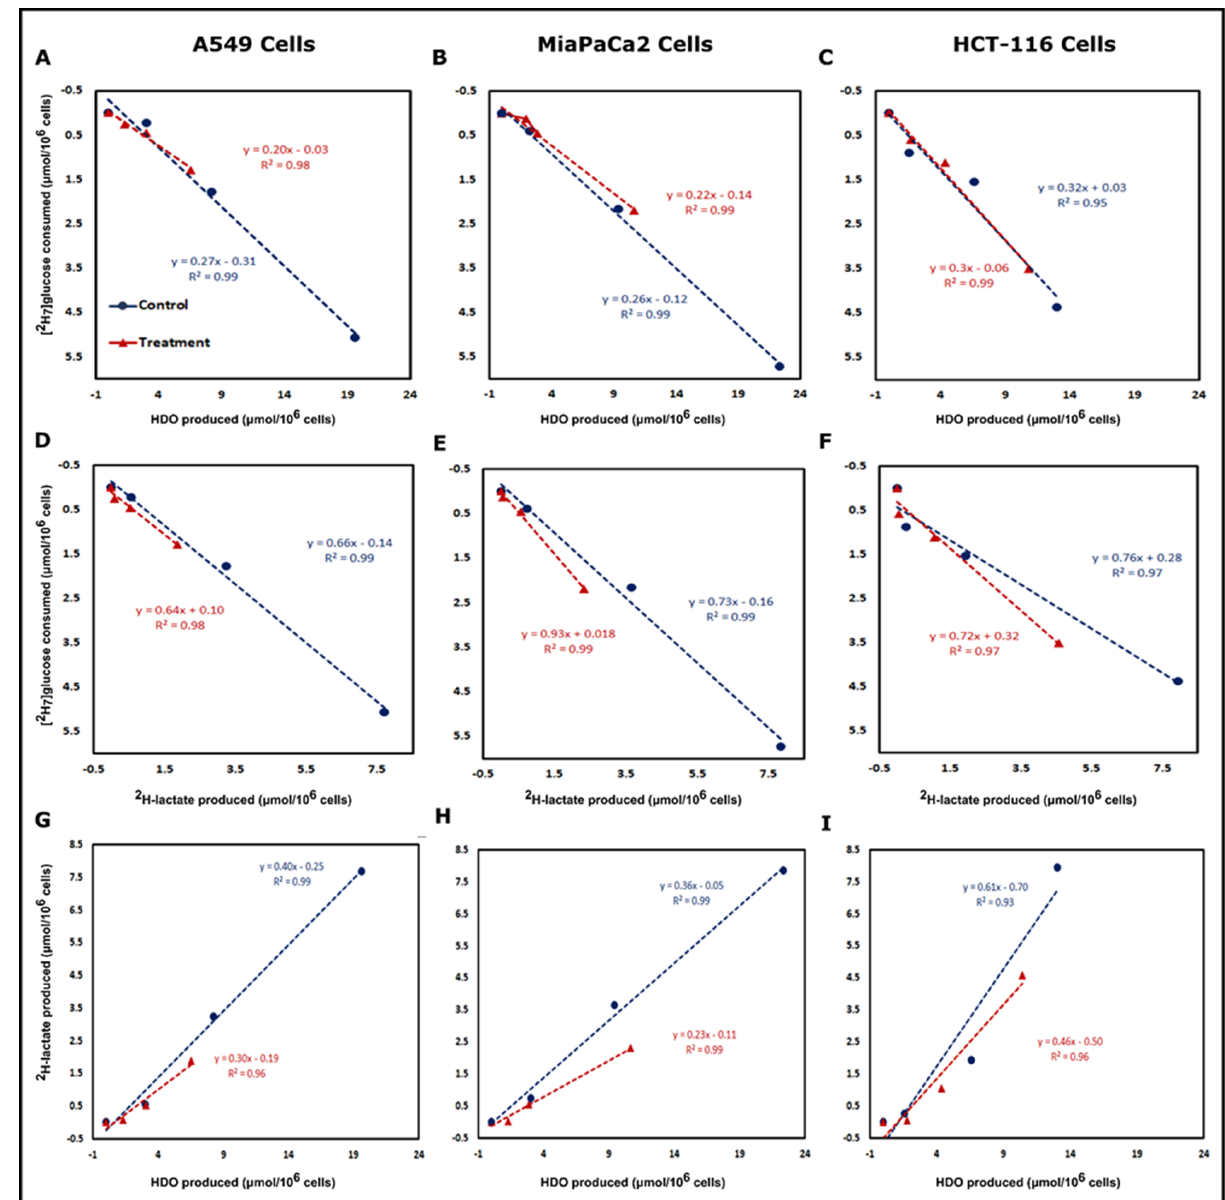
Figure 4. HDO and 2 H-lactate production are directly related to [ 2 H 7 ]glucose consumption. Correlation plots of [ 2 H 7 ]glucose consumption vs. HDO production (top row) and 2 H-lactate production (middle row) and correlation between 2 H-lactate vs. HDO production (bottom row) are shown for the post-treatment period of A549 (Panels A , D and G ), MiaPaCa2 (Panels B , E and H ) and HCT-116 (Panels C , F and I ). Correlations in all conditions were linear with R 2 values > 0.96. Correlation plots were plotted from the calculated concentration of consumed [ 2 H 7 ]glucose and produced 2 H-lactate and HDO by control and treated cells. The excellent linearity between 2 H-lactate and HDO production and higher production of HDO demonstrates that the HDO could be a much more sensitive marker than lactate for monitoring NQO1 bioactivation.